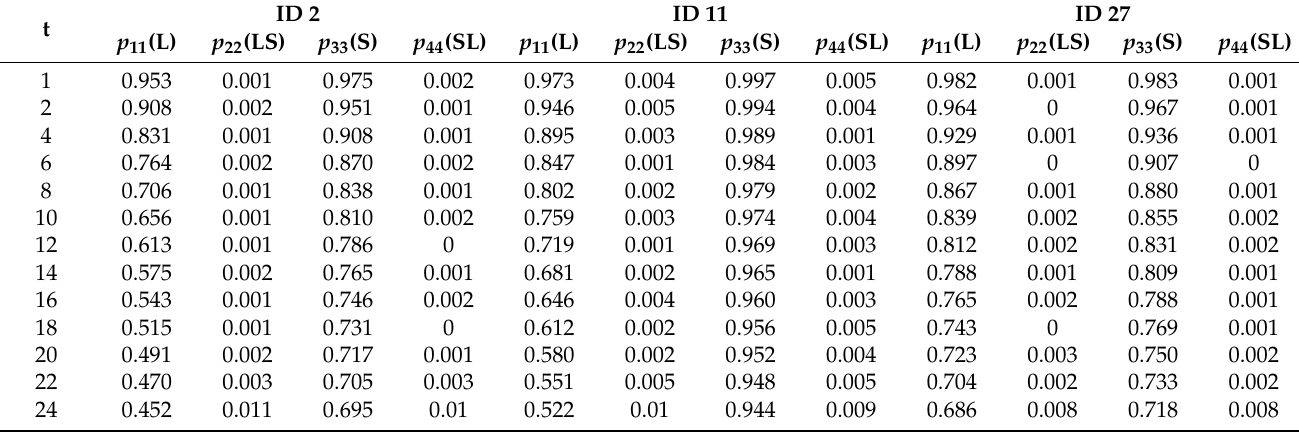
Table 3. State probability patterns of ID2, ID11, and ID 27.